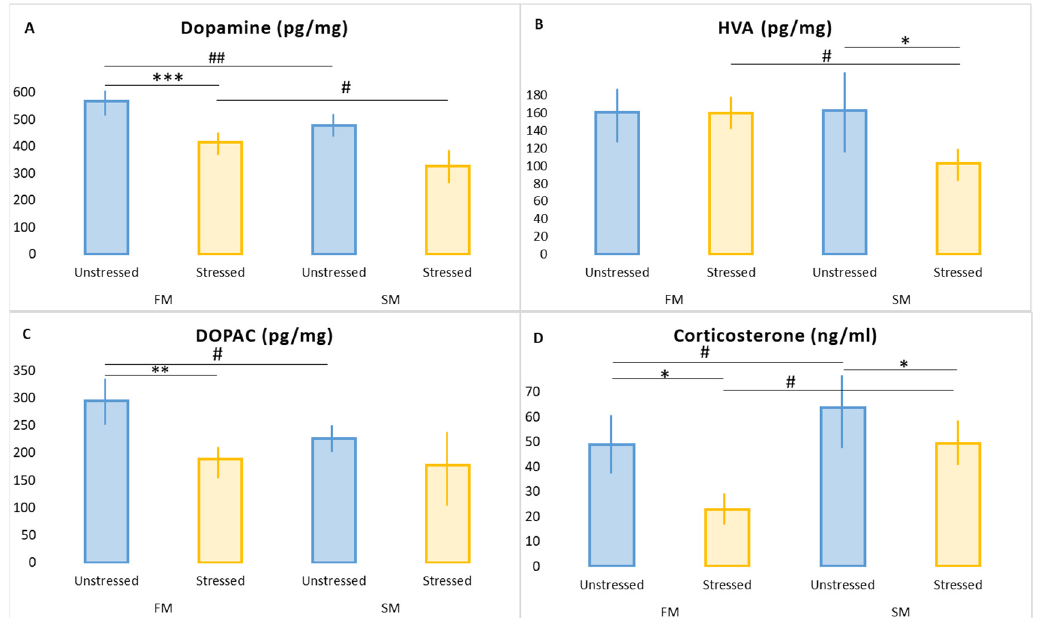
Figure 1. Hippocampal DA ( A ), HVA ( B ) and DOPAC ( C ), and plasma CORT ( D ) in SM and